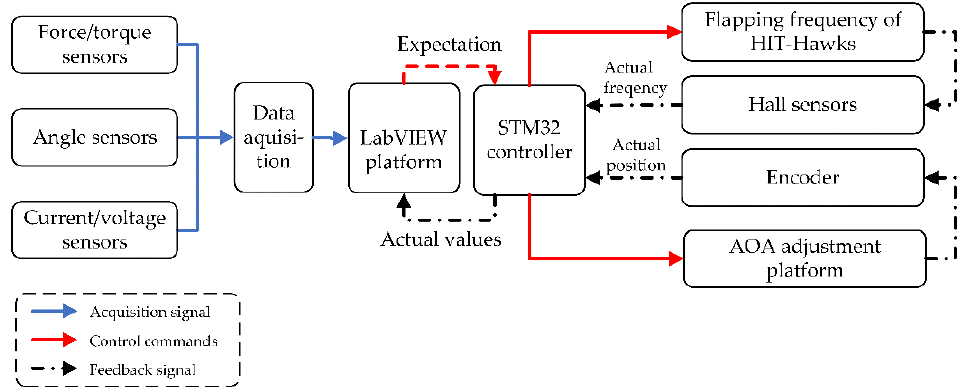
Figure 6. Block diagram of signal acquisition and motion control system principles for the wind tunnel experiment platform.